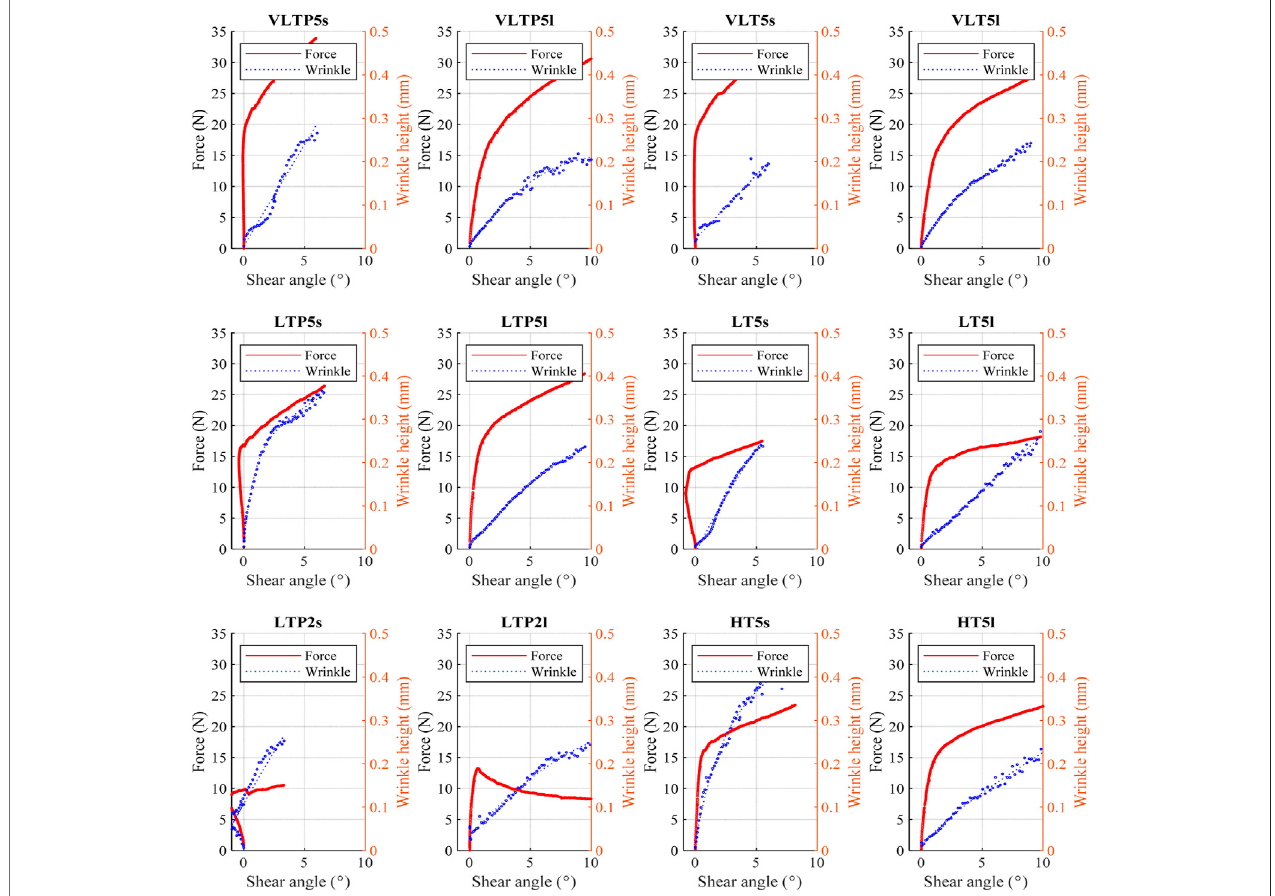
FIGURE 8 | Force and wrinkle versus shear plots for six NCF formats, stitch and loop side shown.